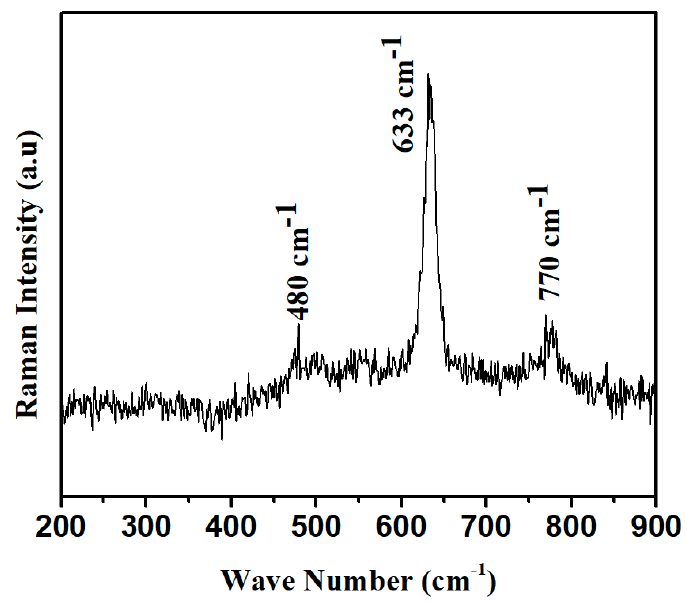
Figure 4. Raman spectra of SnO 2 nano-powder.